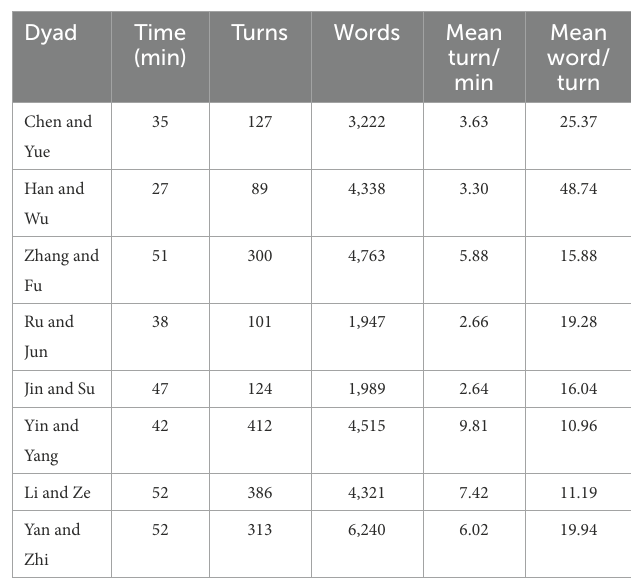
TABLE 5 Results for behavioral engagement.